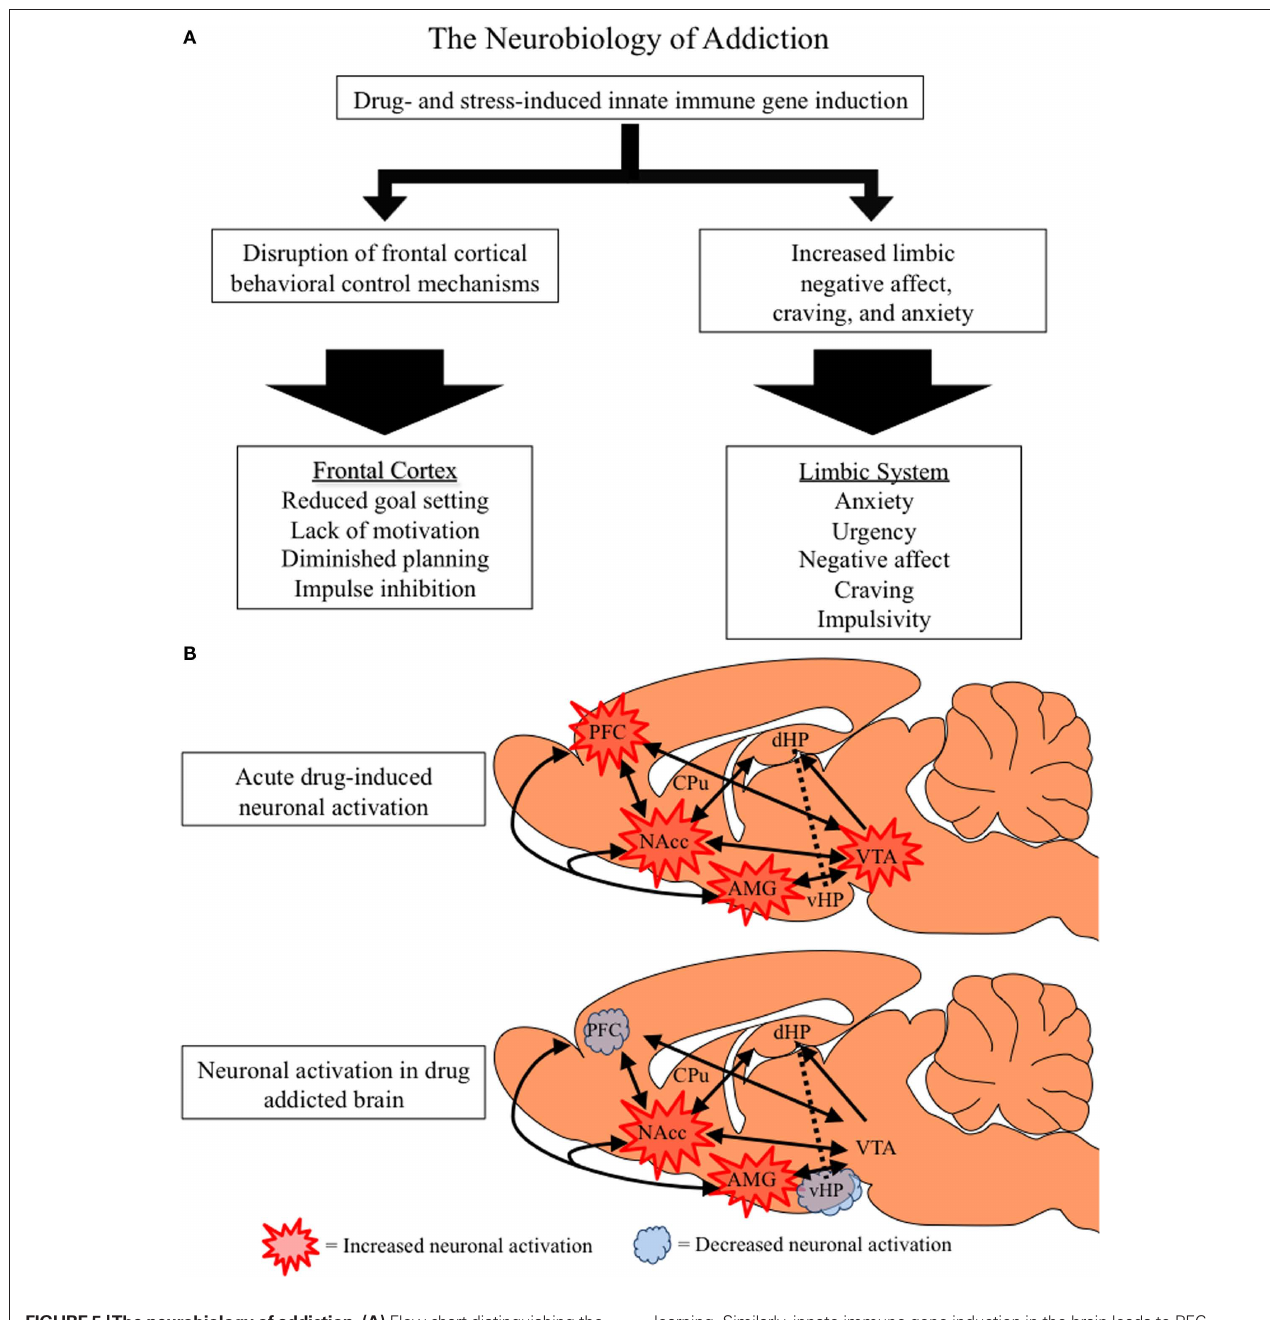
Figure 5 | The neurobiology of addiction. (A) Flow chart distinguishing the frontal–cortical and limbic changes associated with drug addiction. Both stress and drug abuse activate innate immune gene expression, which increases limbic activation and disrupts frontal–cortical function. (B) A simplified schematic of the frontal–cortical and limbic circuitry that contributes to addictive behavior. Depicted is a rat brain with internal structures highlighted and accompanying projections (as indicated by black arrows). The frontal–cortical areas include the medial prefrontal, anterior cingulate, and orbitofrontal cortices, and are involved in attention, goal setting, planning, and impulse control (Schoenbaum et al., 2006; Schoenbaum and Shaham, 2008). The limbic circuitry, comprising the nucleus accumbens (NAcc), amygdala (AMG), hippocampus (HPC), and ventral tegmental area (VTA), is involved in emotion, learning, and memory. Acute drug abuse activates frontal–cortical attention mechanisms, prompting limbic